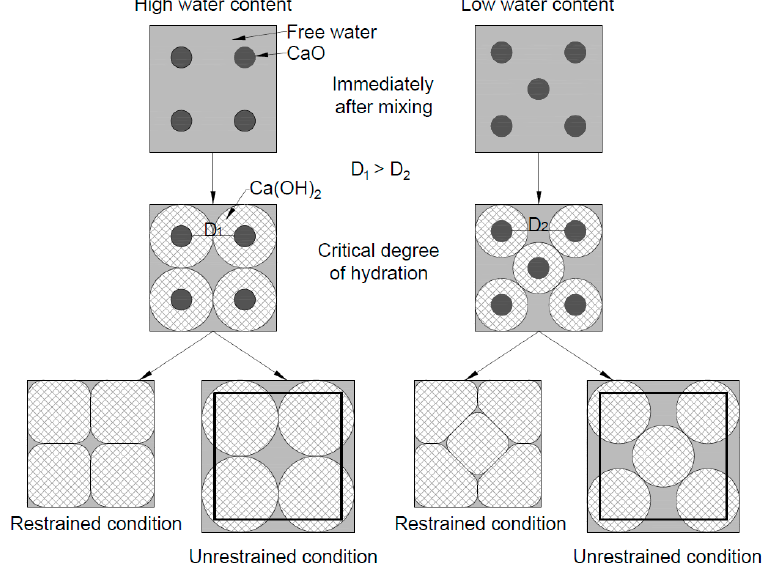
Figure 5. Shalom’s sphere model for expansive mechanism of Ca(OH) 2 [66].